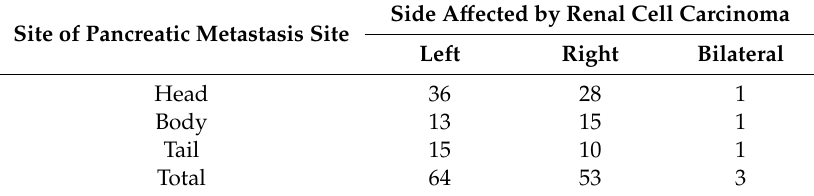
Table 4. Correlation between side of renal cell carcinoma and site of metastasis within the pancreas ( N = 120; p =